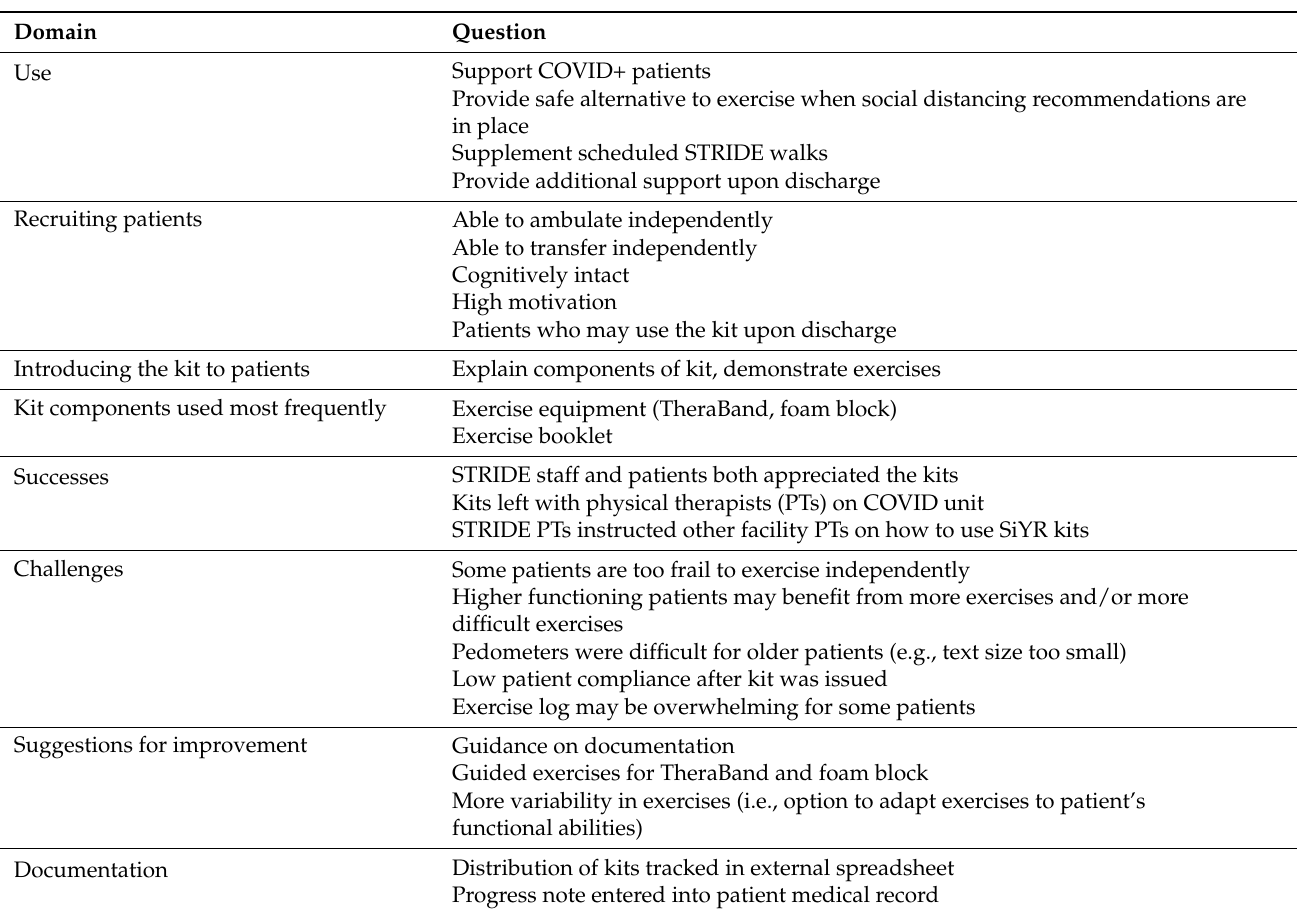
Table 4. Selected feedback received from participating